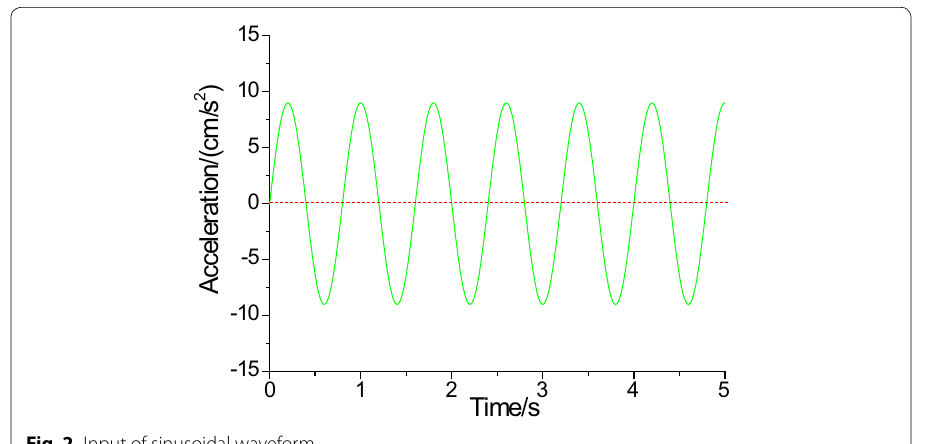
Fig. 2 Input of sinusoidal waveform